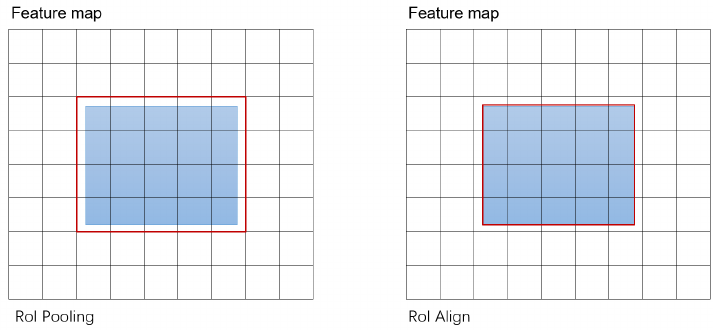
Figure 3. Comparison of RoI Pooling and RoI Align calculation methods.